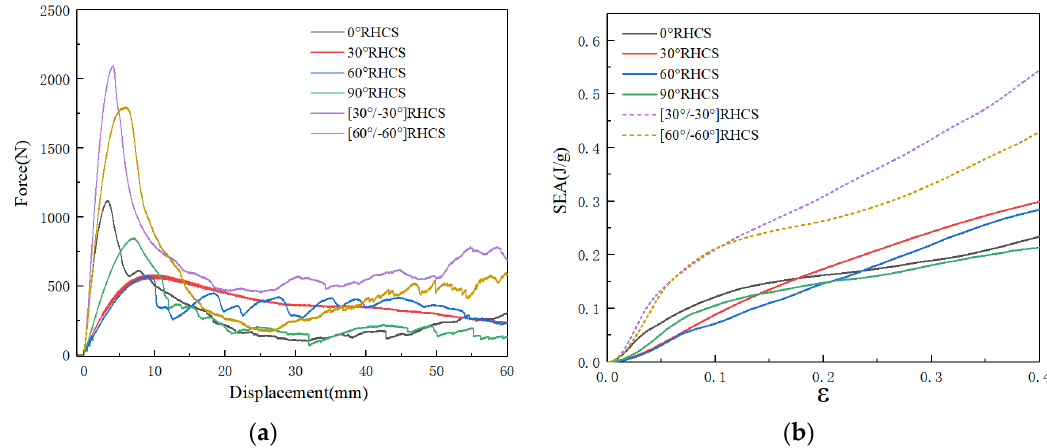
Figure 12. Quasi-static compression: ( a ) the force–displacement curves of RHCSs; ( b ) the SEA curves of RHCSs.